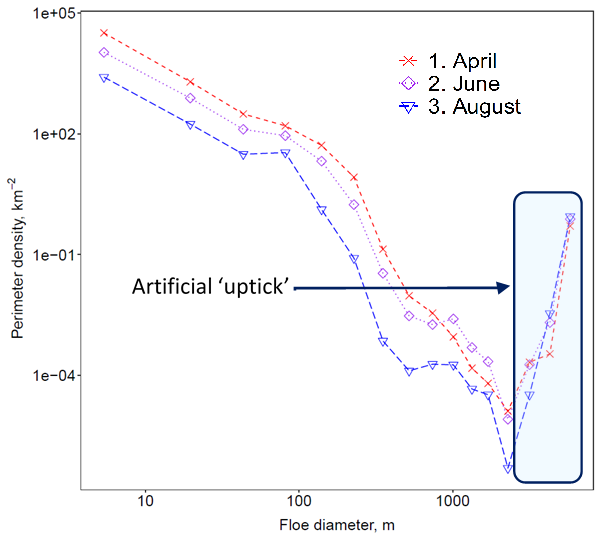
Figure 2. An example of prognostic model output from the prog-16- nobf simulation averaged over the MIZ (i.e regions with between 15%–80% sea ice concentration). Presented in the figure is the perimeter density distribution, per square kilometre for April (red, cross, dashed), June (purple, diamond, dotted), and August (blue, triangle, long dashed) averaged over 2000–2016. Also highlighted in the figure by a blue transparent box is an artificial “uptick”, a fea- ture of the model also reported by Roach et al. (2018) that results from prognostic model design and structure (e.g. missing fragmen- tation processes, upper limit on floe size) and does not represent a physical behaviour seen for the